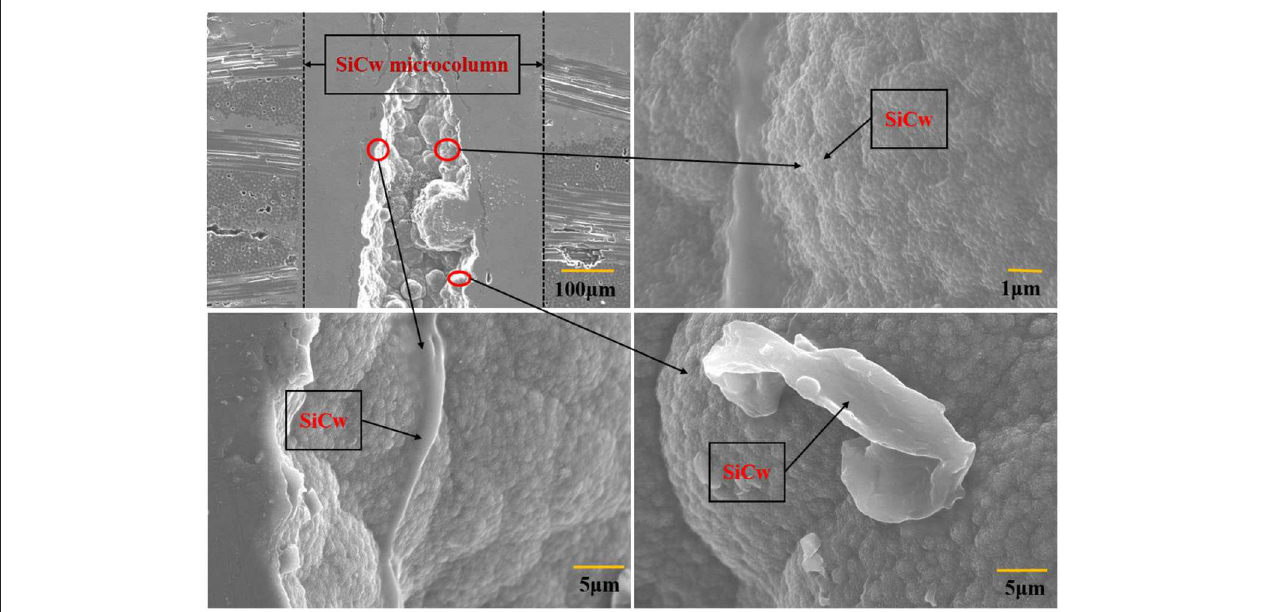
TABLE 1 | Properties of LA-CVI-C/SiCw/SiC and CVI-C/SiC composites. Sample